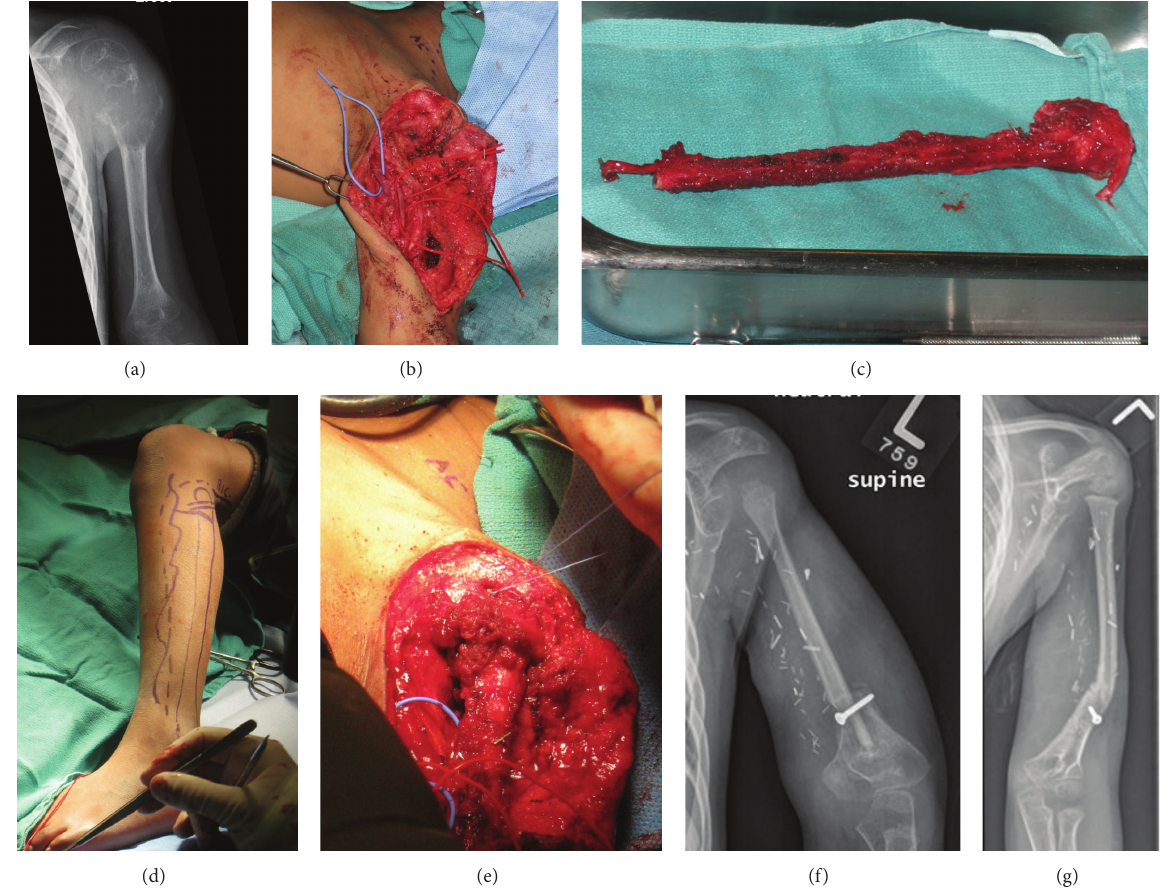
Figure 1: Operative pictures and nonoperative treatment of graft fracture. (a) Preoperative radiograph of osteosarcoma involving proximal humerus. (b) Intraoperative picture of resected tumor bed. (c) Resected tumor and proximal humerus. (d) Intraoperative planning of fibular resection. (e) Intraoperative reconstruction of proximal humerus with proximal fibula including growth plate. (f) AP radiograph immediately after operation. (g) Healed fracture through fibular graft with nonoperative treatment.